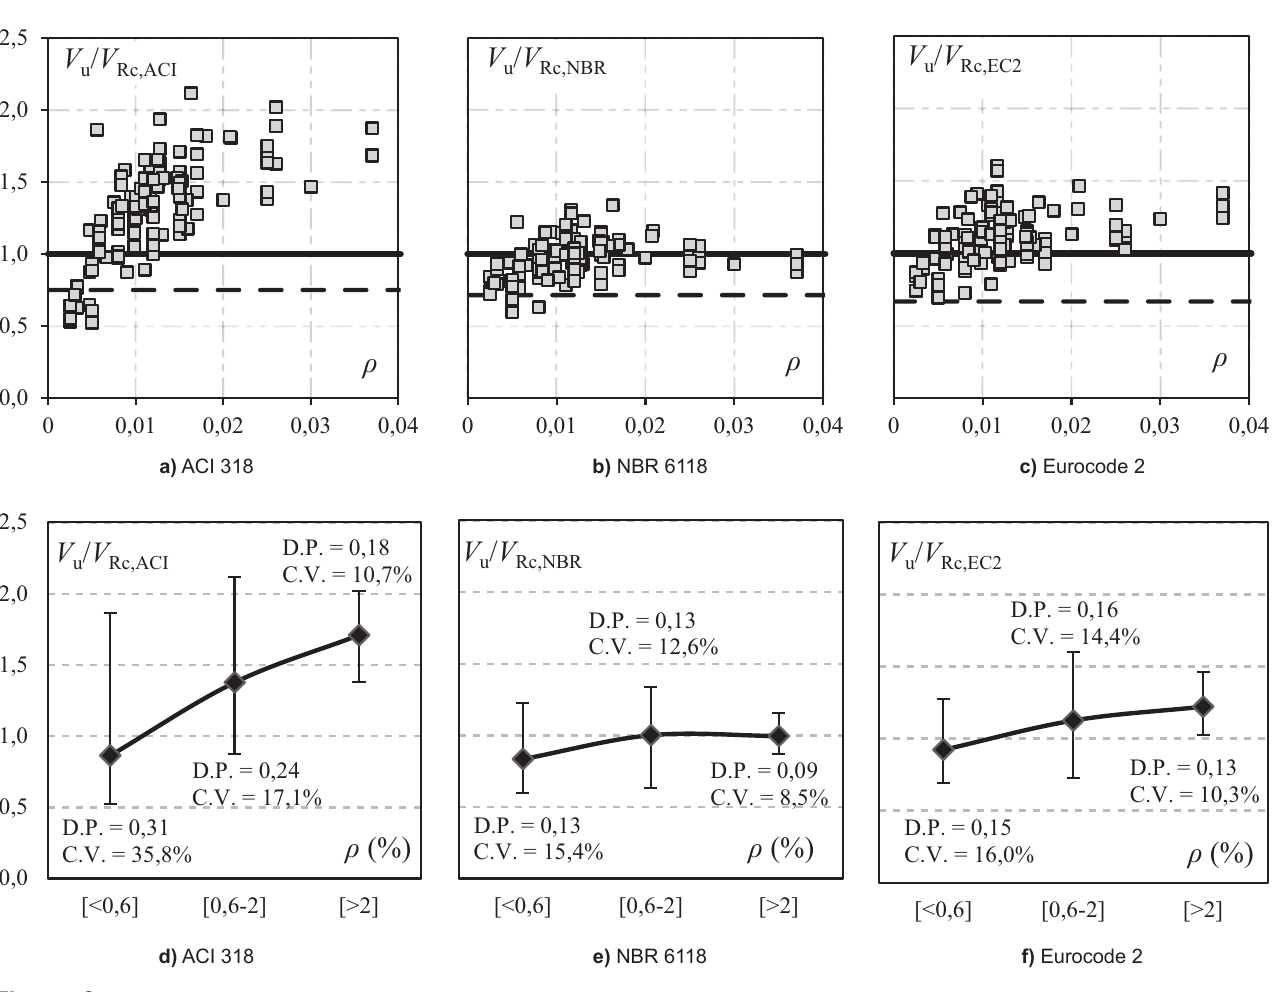
Influência de ρ no desempenho das normas para lajes sem armadura de